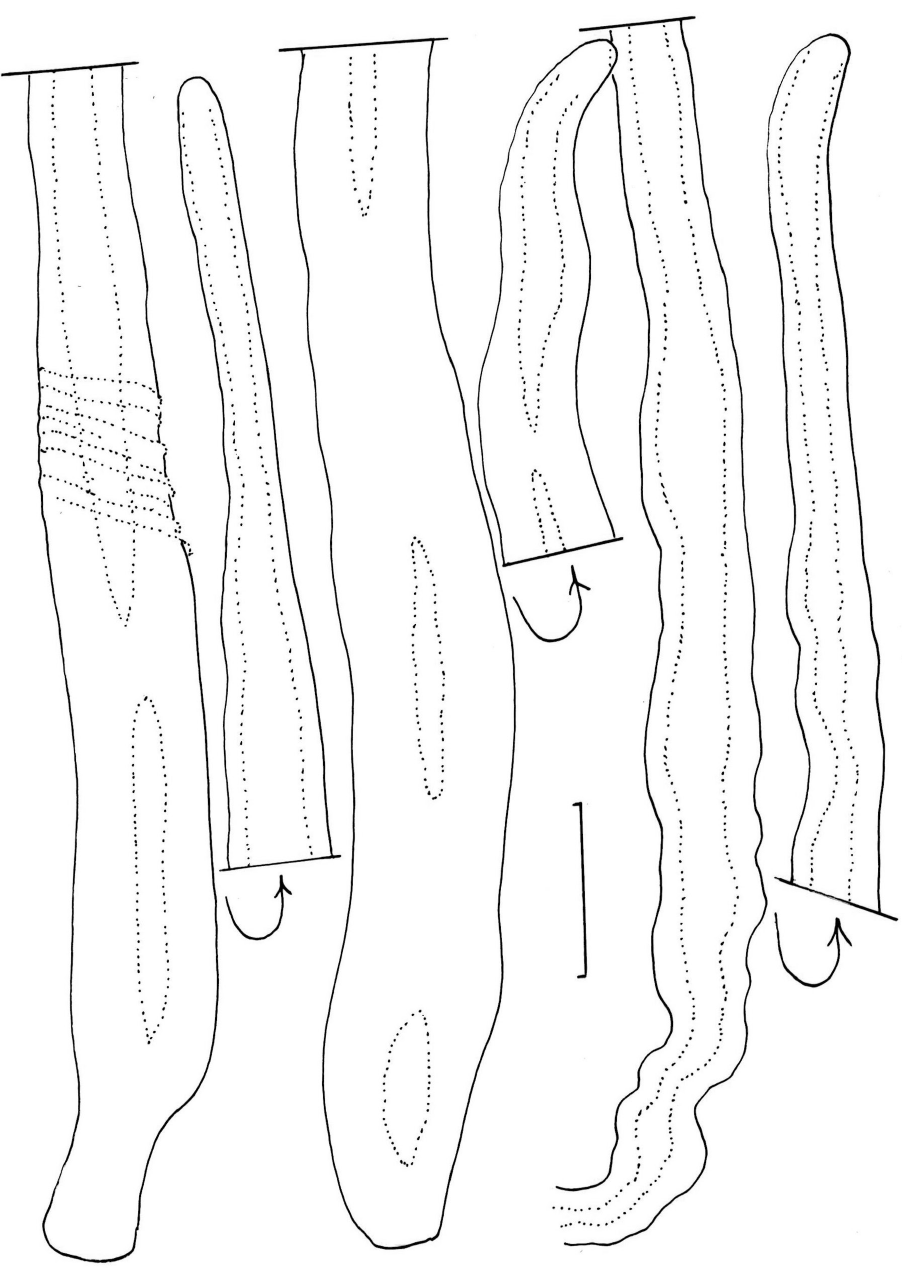
Figure 27. Mycetinis copelandii . Caulocystidia from stipe base. Standard bar = 20 µm. TFB 8084 (TENN-F-